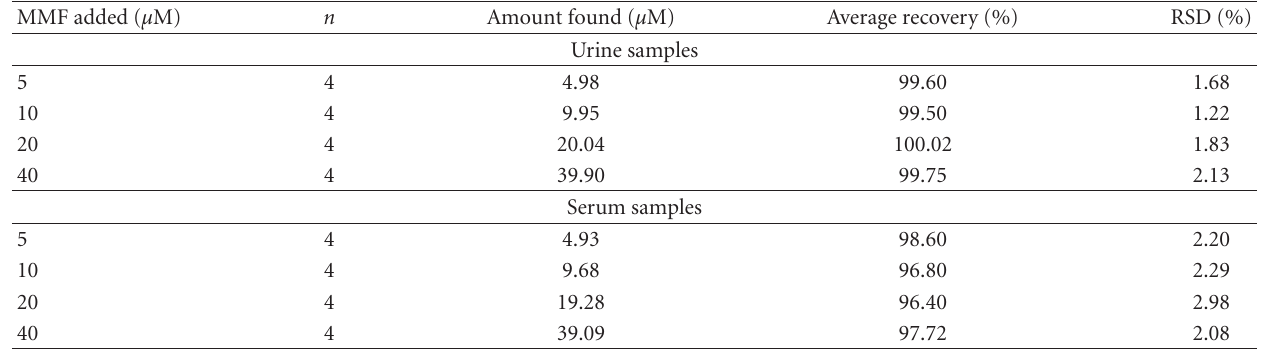
Table 4: Results of analysis of MMF in spiked urine and serum samples.